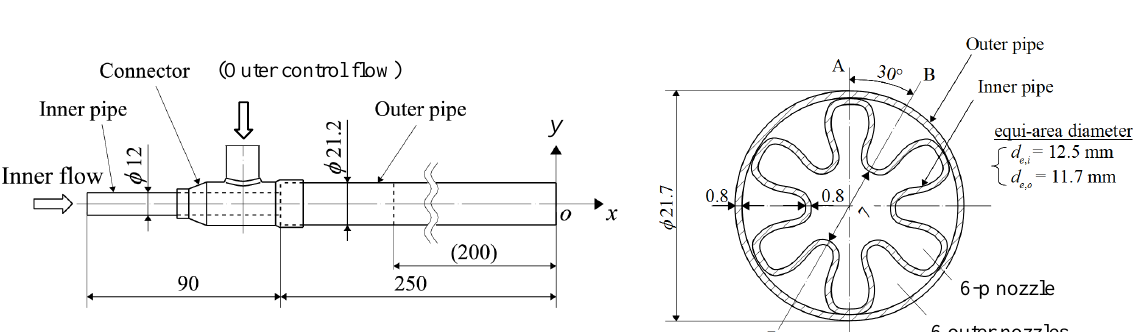
Fig.1 Schematic diagram of 6 petal shaped nozzle.